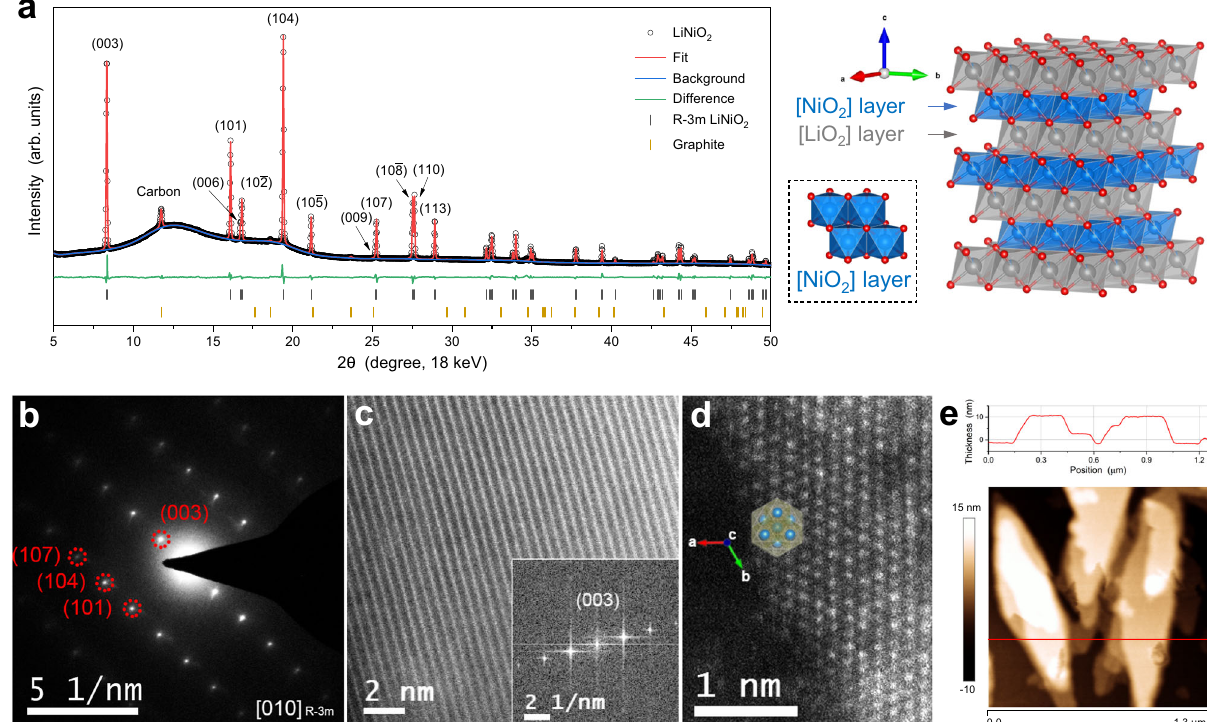
Fig. 2 | Structural characterization of the as-prepared LiNiO 2 . a A synchrotron XRD pattern (18keV incident beam energy, λ =~0.6888Å) and a Rietveld re fi ne- ment fi t with the re fi ned structural parameters listed in Supplementary Table 1, along with the structural model of R-3m LiNiO 2 which consists of alternate [LiO 2 ] and [NiO 2 ] layers formed by edge-sharing [LiO 6 ] or [NiO 6 ] units. A set of extra diffraction peaks are from graphitic carbon of carbon paper and two broad